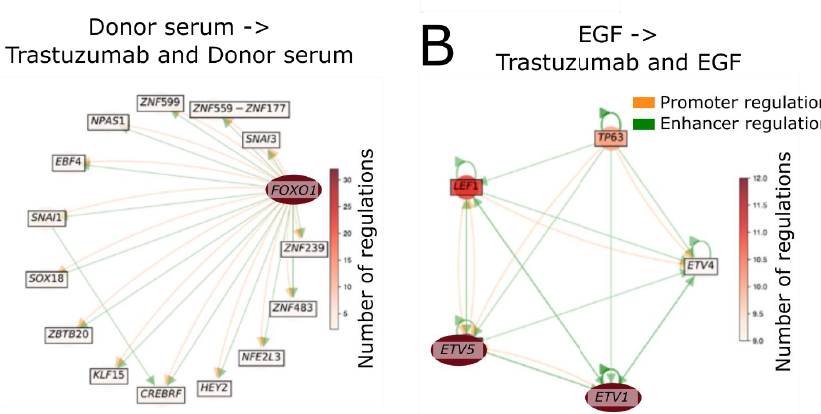
Figure 10. Heatmap for CMAP analysis of differentially expressed genes in the three comparisons of BT474 cells with/without trastuzumab added. ( A ) Nothing vs. Trastuzumab and ( B ) EGF vs. EGF and Trastuzumab. CP—compound, OE—overexpression, KD—knock-down, PCL—perturbagen class, CTRL—control. Red color indicates that Trastuzumab acts in a similar manner to the perturbation shown, blue color—in an opposite way. Adapted from clue.io output.